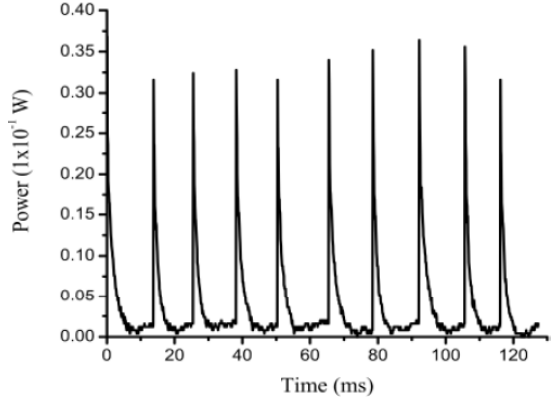
Fig. 1. Chiu’s experimental setup. The laser light in the chamber has the form of a truncated cone.  the distance between the common focus and the chamber’s middle place, is varied to modify the la- ser intensity.